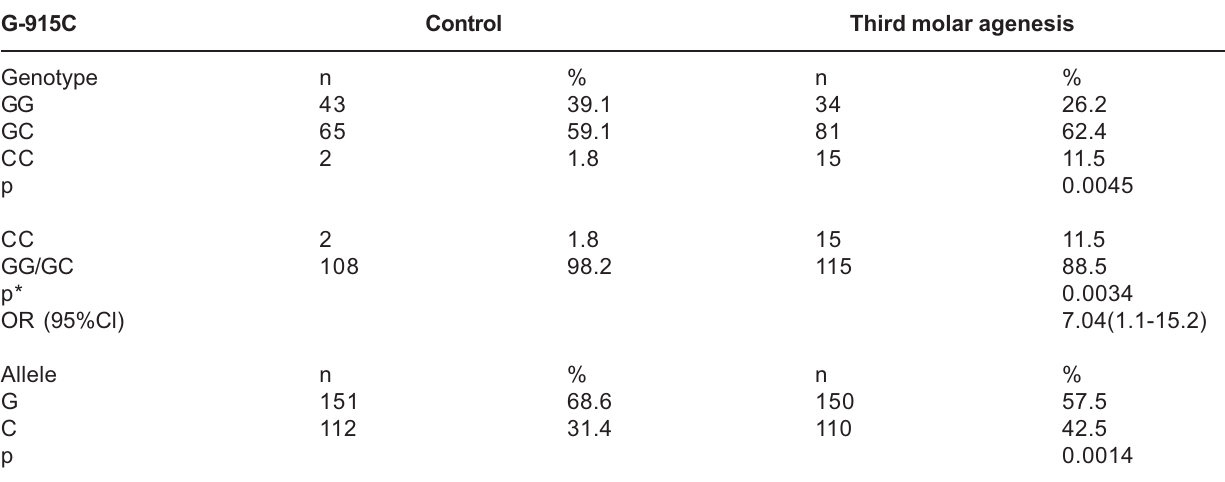
TABLE 1- Genotype and allele distribution of the G-915C polymorphism of PAX9 gene in the control and hypodontia (third molar)